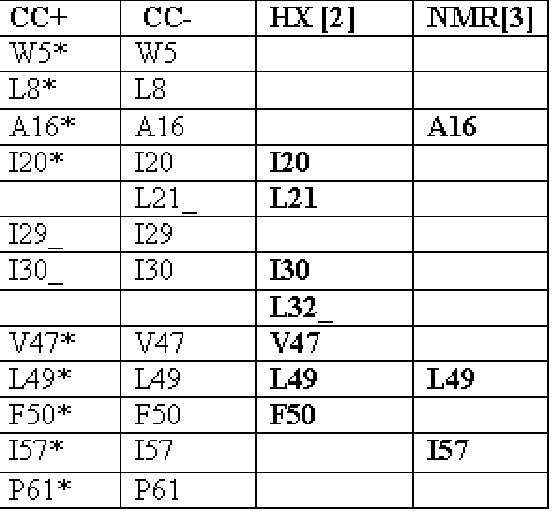
FIGURE 1. Stages of protein folding using CI2 as an example. a) local hydrophobic collapse; b) formation of the residue cluster(s) around the charge centers, then electrostatic collapse; c) global hydrophobic collapse , formation of the active/binding site; (d) slow annealing to the native state. HX (hydrogen exchange) residues (cyan), continuous hydrophobic sequences (green dots), residues of folding nucleus (yellow), charge centers (positive, blue sphere, negative, red) and the binding site (loop colored in red) are shown. See text for the details on biochemistry of CI2 folding. Residues around the positive and negative charge centers (CC+,CC-), of the hydrogen exchange core (HX) and of the folding nucleus (NMR) for CI2 from barley (PDB 1ciq). Only hydrophobic residues are listed. Conserved residues are marked with ‘*’. Residues in this table comprise less than 1/3 of all hydrophobic residues in